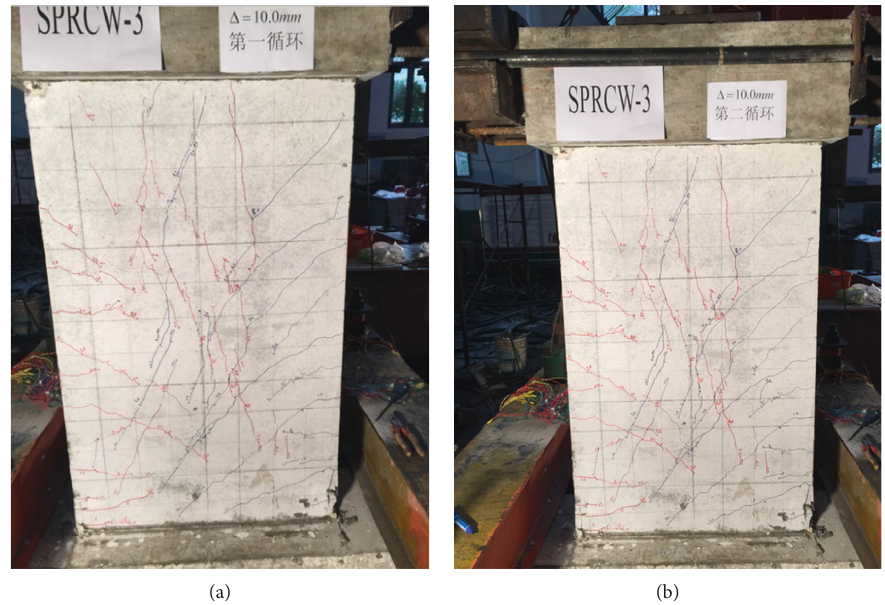
Figure 16: Diagram of cracks in the Δ � 10mm displacement cycle. (a) First cycle. (b) Second cycle.